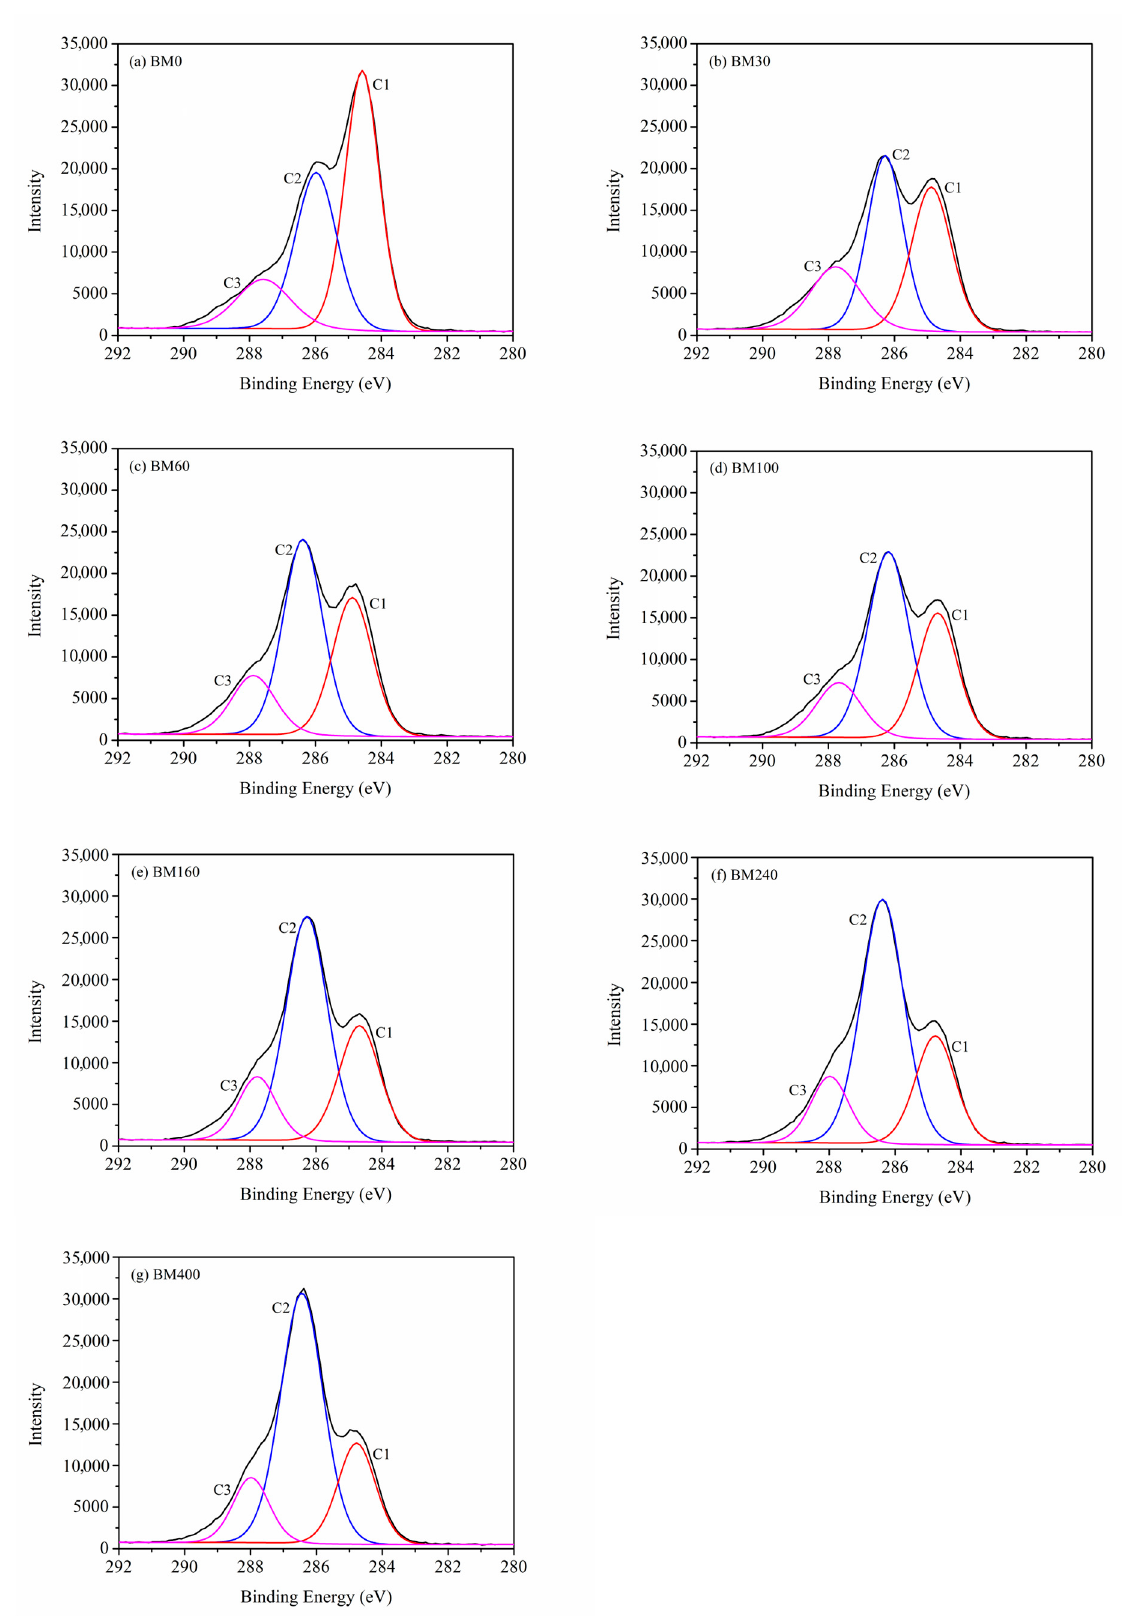
Figure 8. Deconvoluted peaks of C1s spectra for PIDF at different scales.